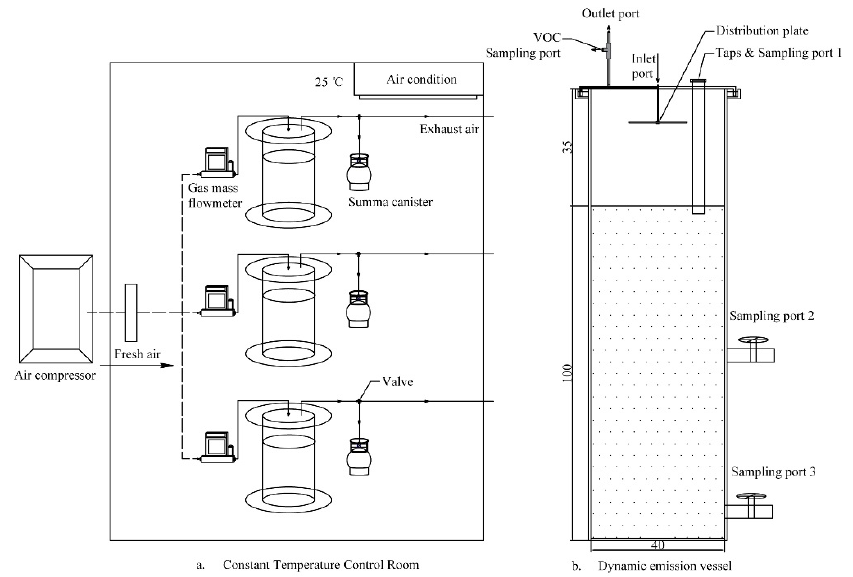
Figure 1. Schematic representation of the experimental setup ( a ) and dynamic emission vessel ( b ).